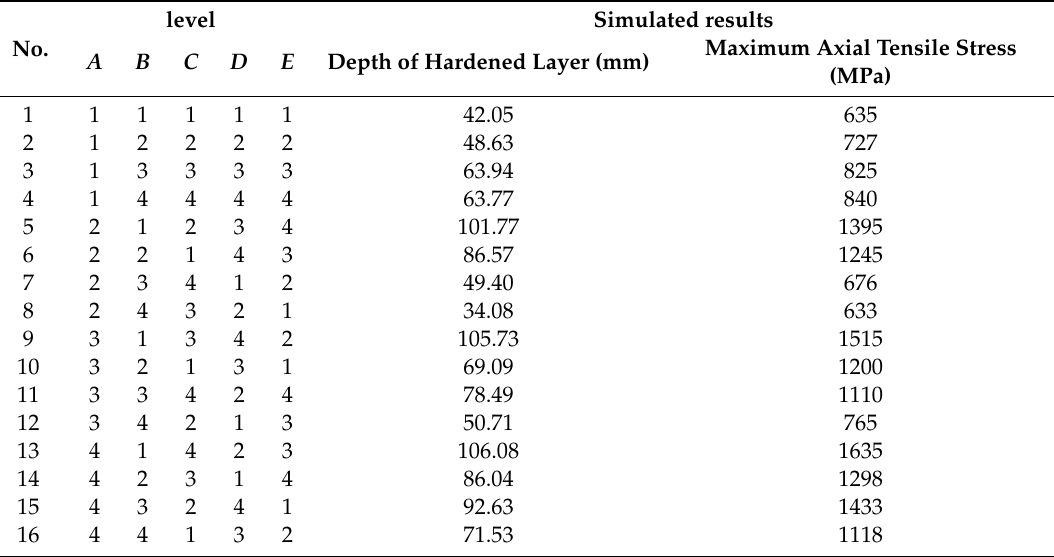
Table 4. L16 (4 5 ) orthogonal level list and simulated indexes.